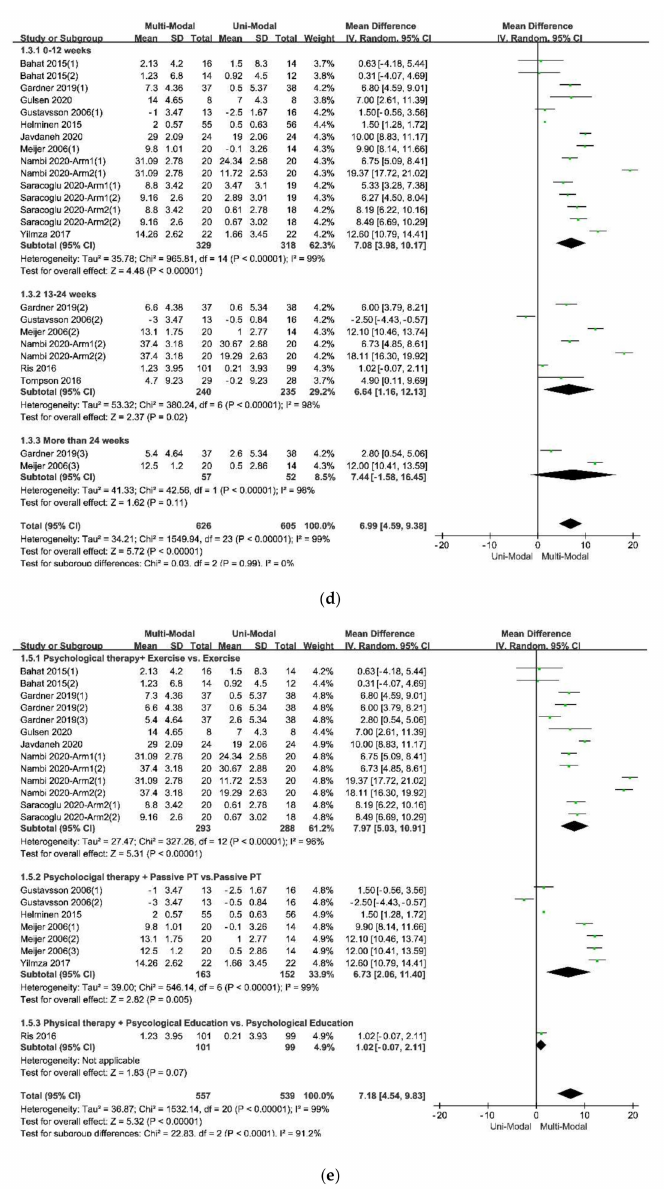
Figure 4. The forest plot of the subgroup analysis: ( a ) The subdivisions of di ff erent types of pain; ( b ) The subdivisions of di ff erent ranges of participants’ mean age; ( c ) The subdivisions of di ff erent durations of treatments; ( d ) The subdivisions of di ff erent follow-up times; ( e ) The subdivisions of di ff erent types of physical therapy in control